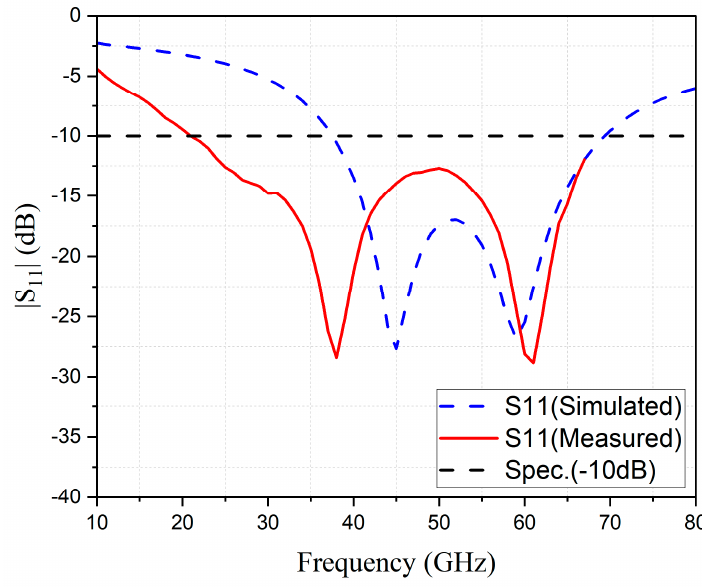
Figure 21. Simulation and measurement of reflection coefficient S11.